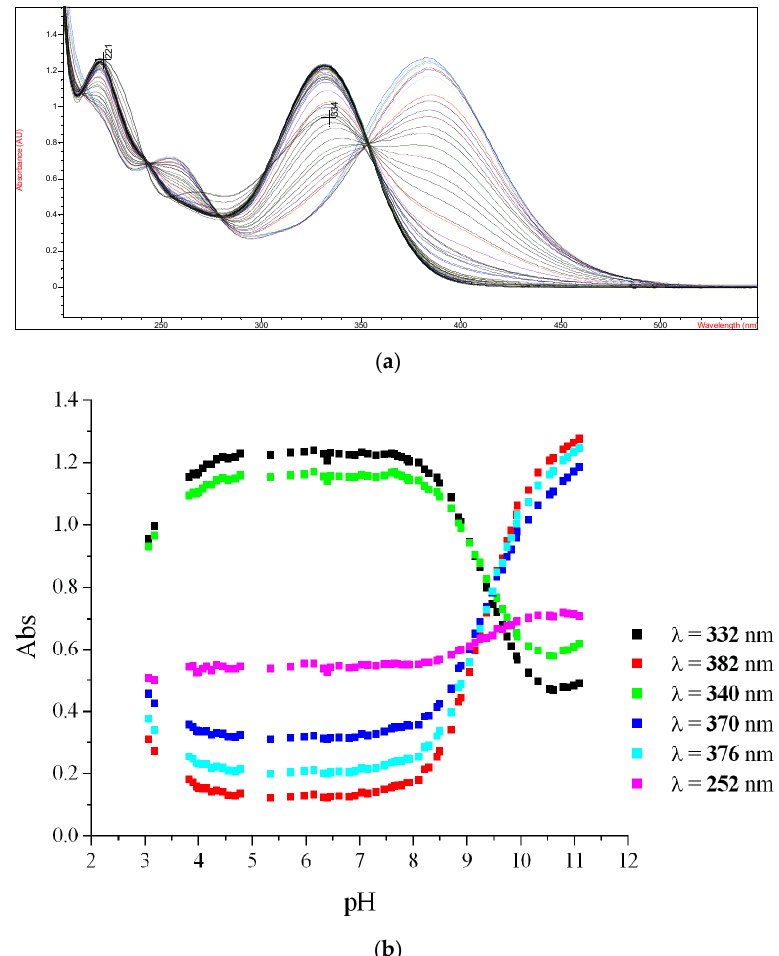
Figure 5. The variations on the UV-vis spectra for compound 1d and the resulting plot for six wavelength values. ( a ) UV-vis spectra obtained for compound 1d as function of pH variation; ( b ) Plots of absorbance for six wavelength values ( λ /nm) as function of pH for compound 1d .